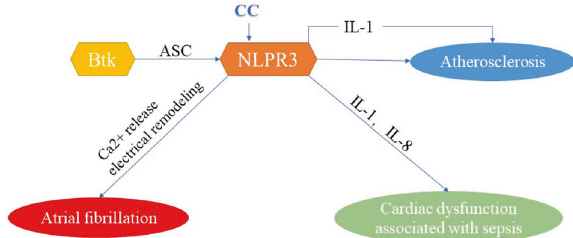
Fig. 3 NLRP3-centered, cardiovascular disease network diagram related to Btk. CC cholesterol crystals, ASC apoptosis-associated speck-like protein containing a CARD, NLRP3 Human NACHT, LRR, and PYD domain-containing protein 3, IL